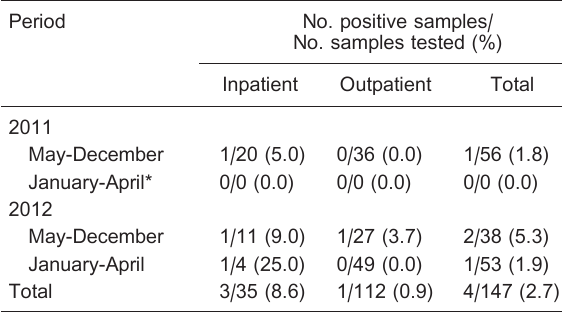
Table 1. Distribution of acute diarrhea and rotavirus-related cases in hospitalized patients and outpatients in Uberaba during